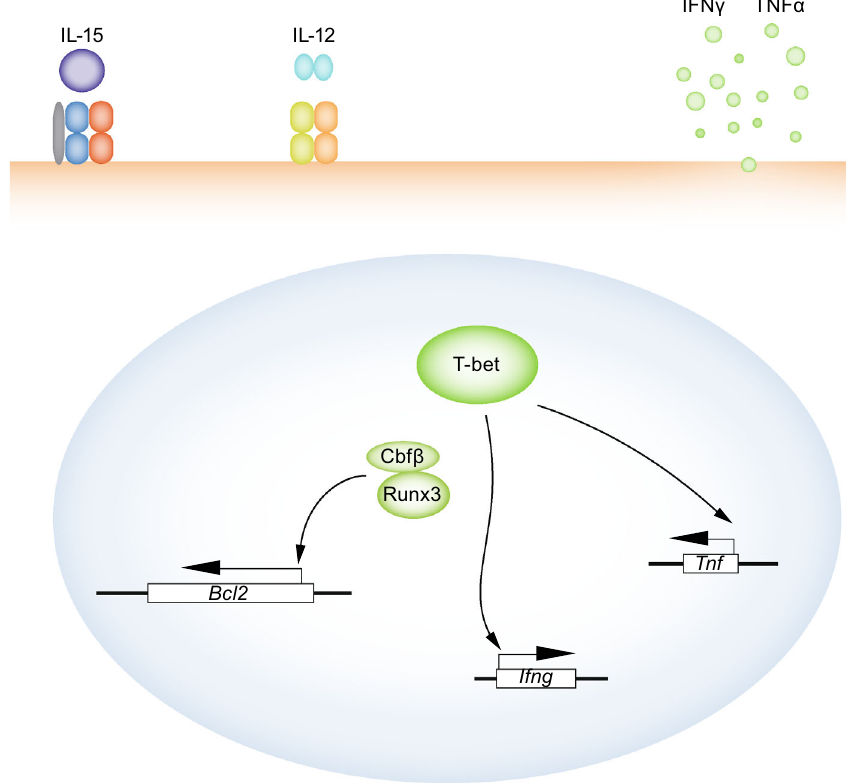
Figure 4. ILC1-speci fi c transcription factors. ILC1 is a newly con fi rmed group 1 ILC population that is distinct from cNK cells. The special functions of ILC1s and underlying regulatory mechanism still need further investigation. T-bet is the master transcriptional regulator of ILC1 cells and regulates the production of ILC1 effector cytokines IFN γ and TNF α . Runx3 and Cbf β are also required for the maintenance of mature ILC1s, mainly through regulating the expression of anti-apoptotic proteins, such as